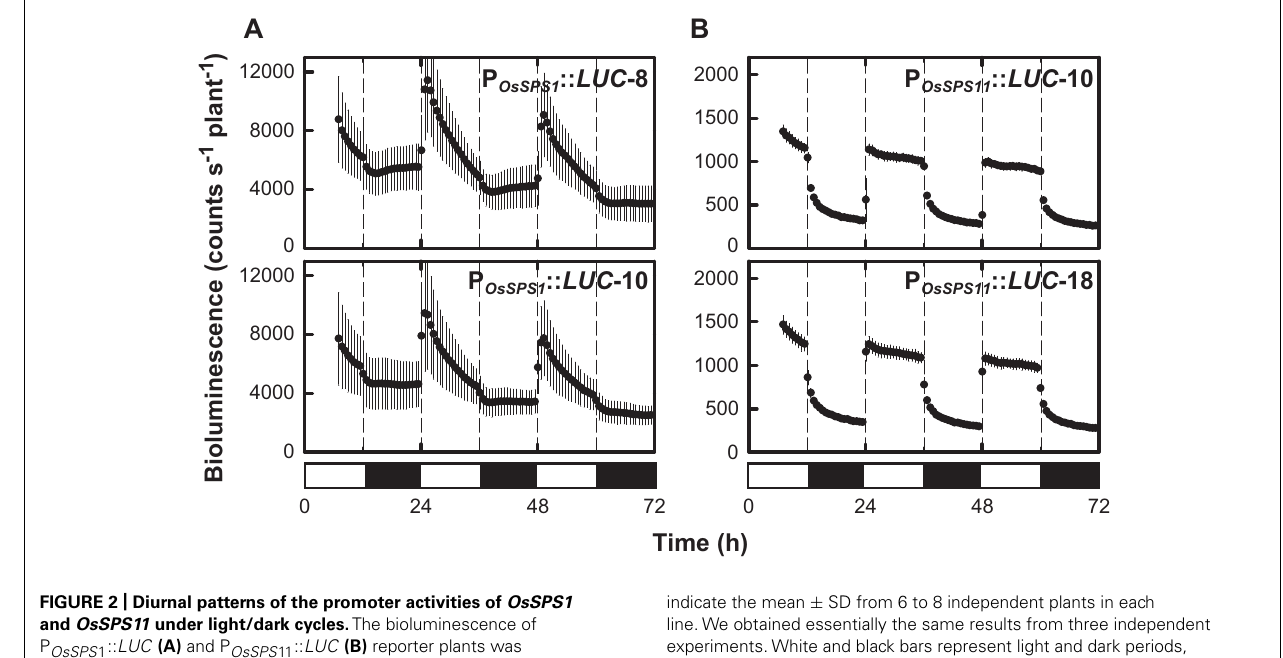
FIGURE 2 | Diurnal patterns of the promoter activities of OsSPS1 and OsSPS11 under light/dark cycles. The bioluminescence of P OsSPS 1 :: LUC (A) and P OsSPS 11 :: LUC (B) reporter plants was measured under 12-h light/12-h dark cycles at 30 ◦ C. Data points